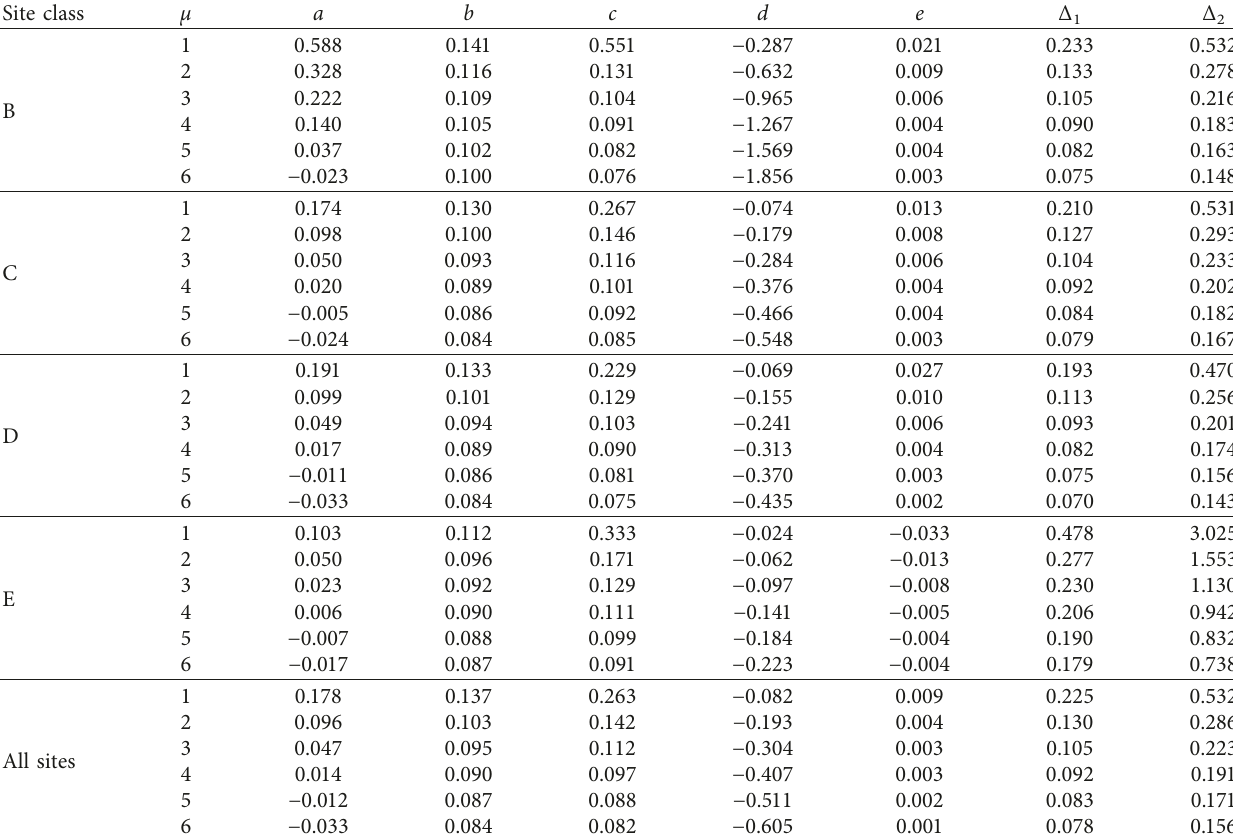
Figure 12: Normalized Δ y for four postyield stiffness ratios and soil site B considering various combinations of T and μ : (a) θ Table 3: Parameters in equation